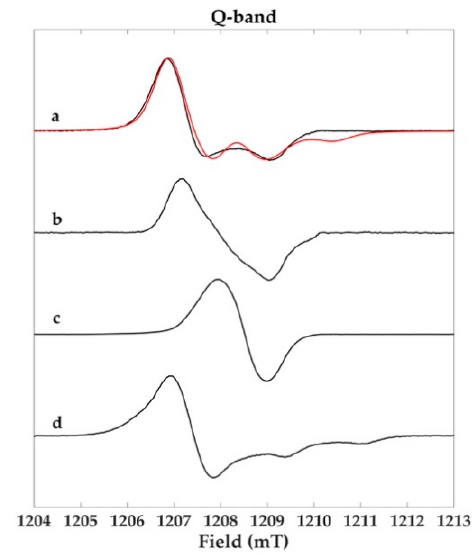
Figure 6. Q-band (33.9 GHz) EPR spectra of ( a ) Sc-Ms1 natural melanin, ( b ) Sc-Ms1 tyrosinase dopa-melanin, ( c ) Tv laccase dopa-melanin, and ( d ) Tv laccase cysteinyldopa melanin samples. Spectra were recorded with 0.06 mW microwave power.